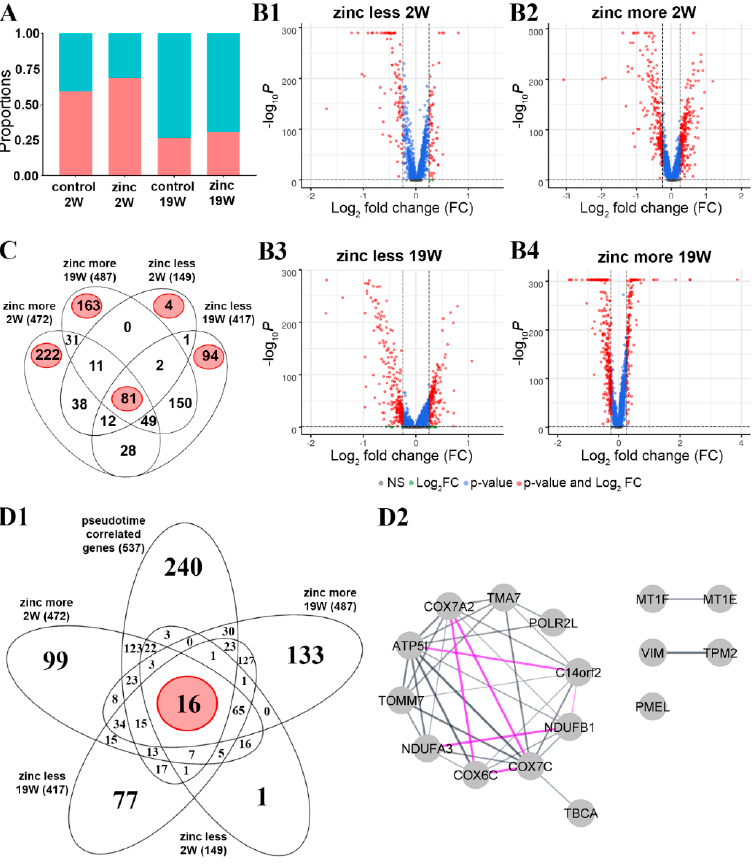
Figure 4. Impact of acute zinc supplementation on in vitro RPE at single-cell level. Relative proportion of less and more differentiated cells over time following acute zinc treatment ( A ); volcano plot visualization of the differentially expressed genes in less ( B1 ) and more ( B2 ) differentiated cells in two-week culture and in less ( B3 ) and more ( B4 ) differentiated cells in 19-week culture; number of differentially expressed genes overlapped amongst the different cell types and culture times ( C ); overlap between pseudotime-correlated genes and differentially expressed genes following acute zinc supplementation ( D1 ) and a network representation of the 16 overlapping genes using Gene Analytics in combination with String and Cytoscape ( D2 ), in which grey lines represent validated connections via text mining, database information, and co-expression, pink lines represent experimentally validated network connection, and the thickness of lines indicates the strength of supporting data.